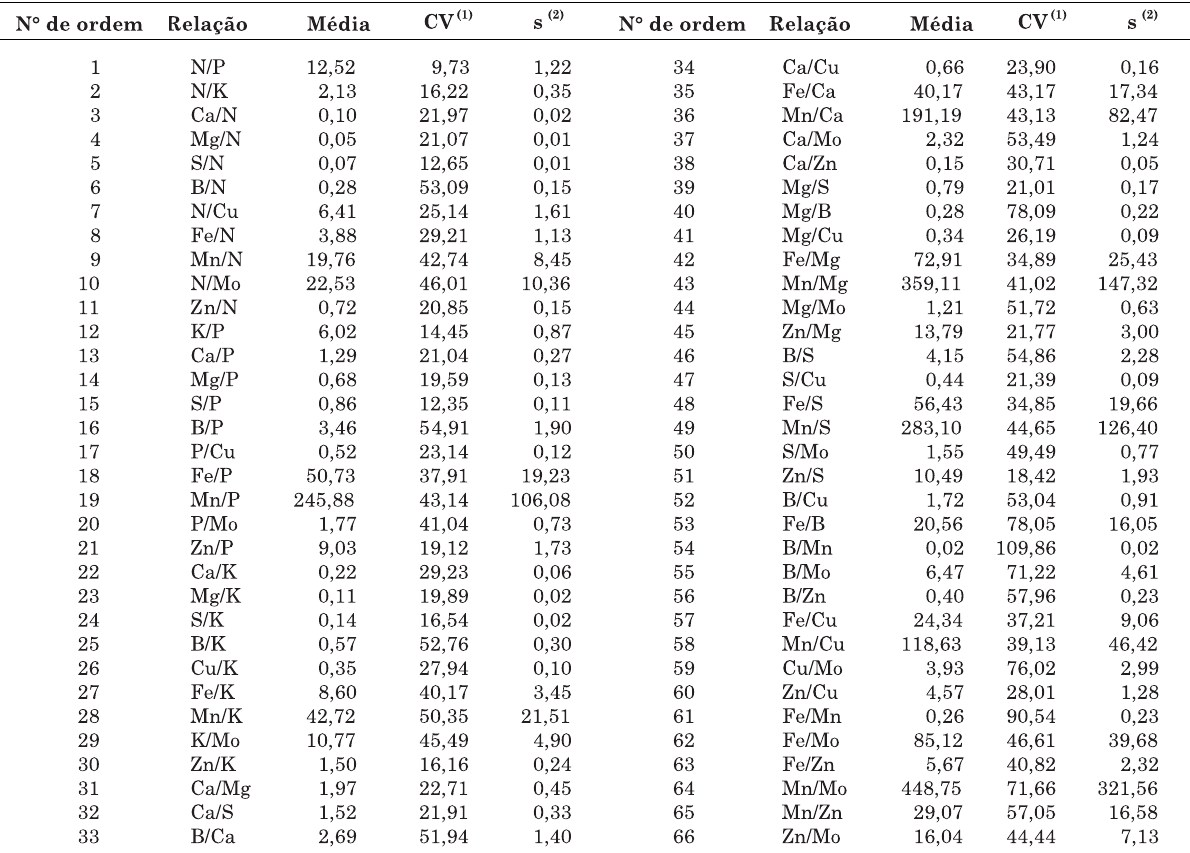
Quadro 2. Norma DRIS para a cultura do arroz irrigado por inundação do Rio Grande do Sul, safra